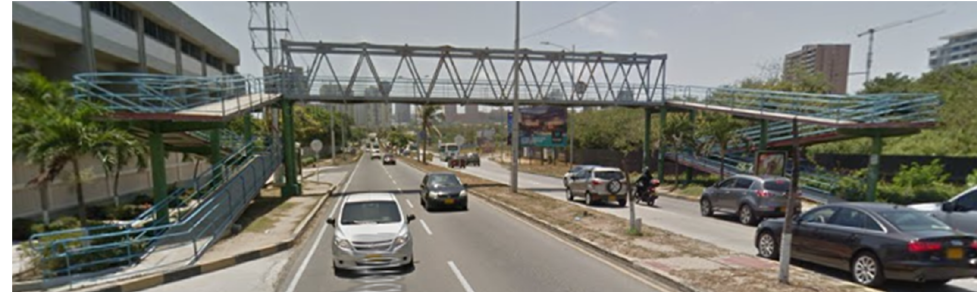
Figure 3. General view for the pedestrian bridges; Warren-type truss (Sagrado).